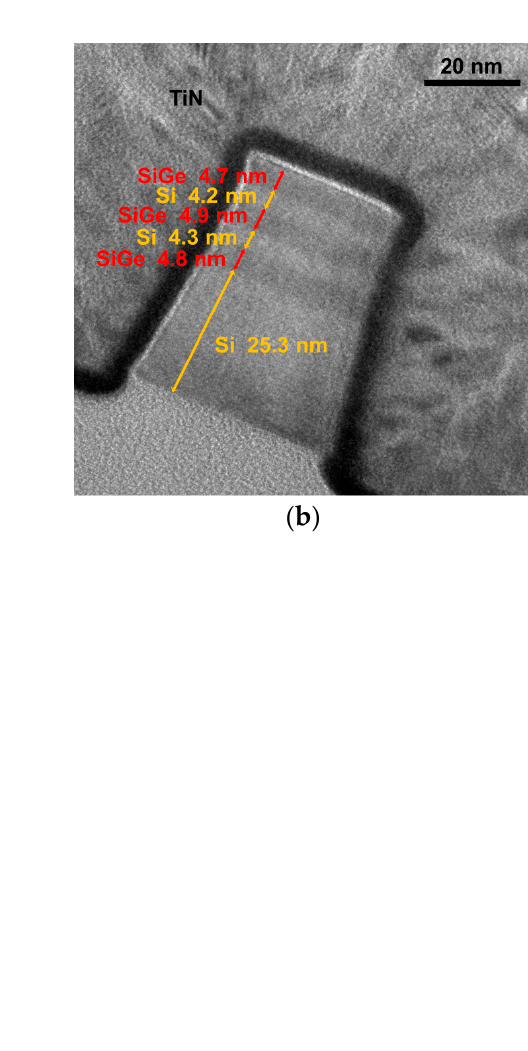
Figure 2. ( a ) TEM image of the Si 0.8 Ge 0.2 /Si SL FinFET with high uniform epitaxy, enlarged view of ( b ) the Si 0.8 Ge 0.2 /Si SL structure with each thickness, and ( c ) interfacial layer of SiO 2 and HfO 2 .